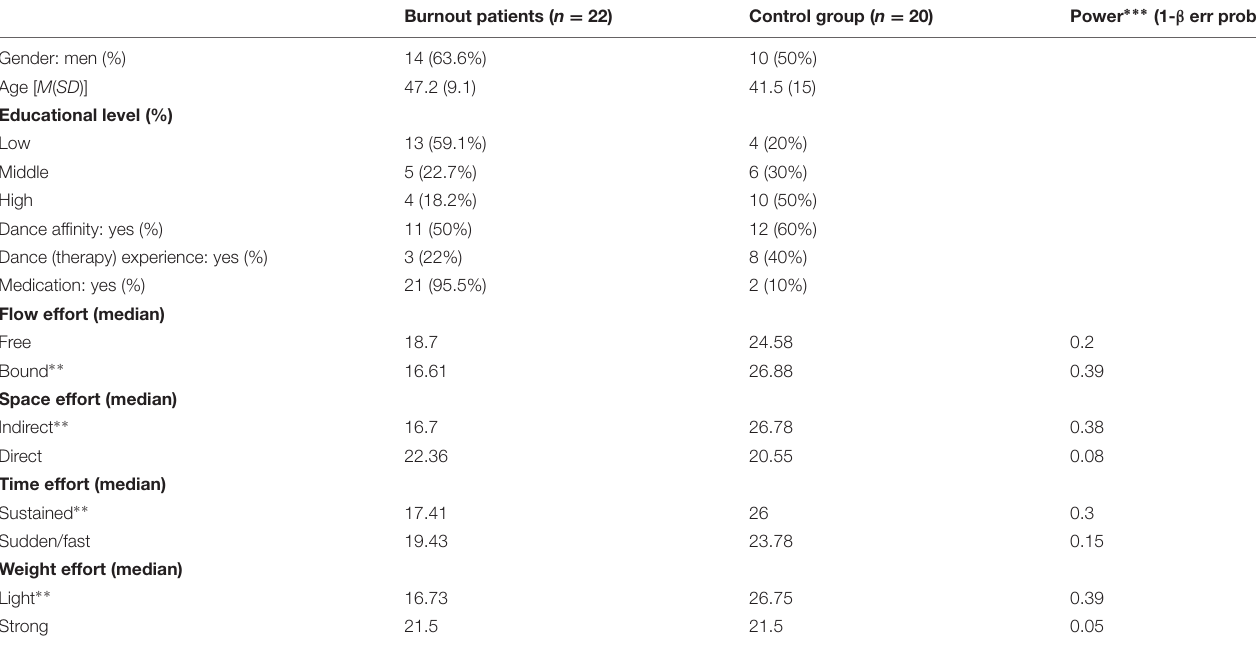
TABLE 2 | Demographic variables, mean ranks of the Mann–Whitney U test (patients/control group) with significances of the dependent variables (LMA) and